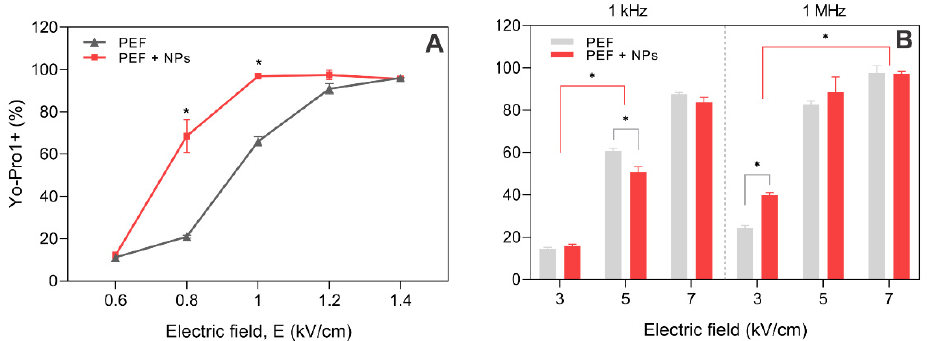
Figure 6. Permeabilization of CHO-K1 cells with the pulsed electric field, where ( A ) ESOPE protocols (100 µs × 8); ( B ) nanosecond burst protocols (300 ns × 100). PEF—pulsed electric field; NPs—gold nanoparticles (13 nm). Asterisk (*) corresponds to statistically significant differences ( p < 0.05).